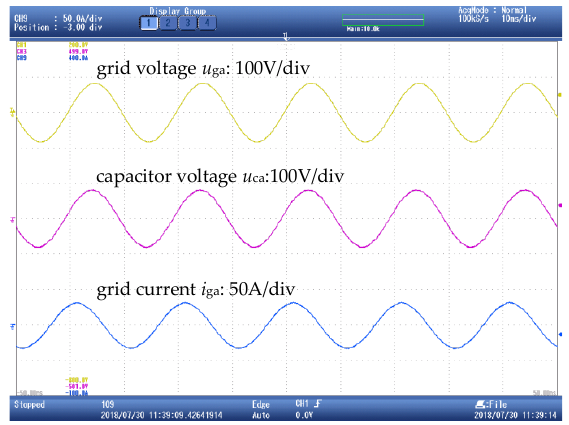
Figure 25. Waveforms of grid voltage u ga , capacitor voltage u ca and grid current i ga with set 1.